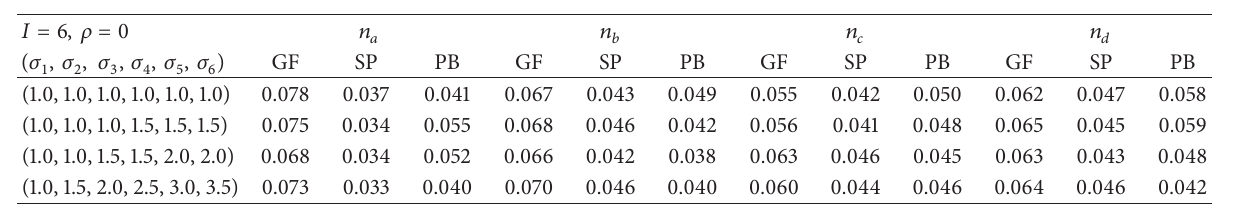
Table 1: Type I error rates of the tests.